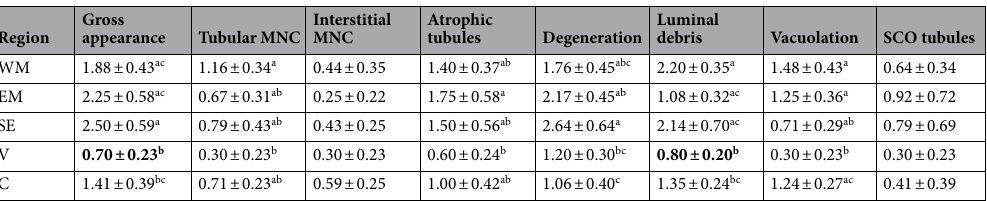
Table 1. Overview of testicular pathologies by geographical region. Data denotes the mean pathology count ± 1 S.D; SCO = Sertoli cell-only; MNC = Multinucleated cells. Differences between superscripts depict significant differences. Bold depicts Vantaa Finland region significantly different to all three UK areas. See text for differences between UK areas.